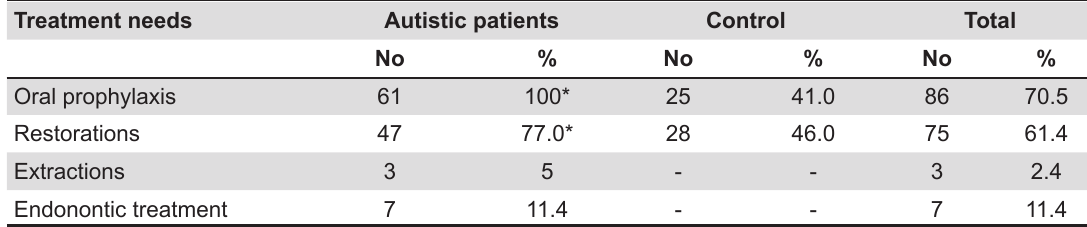
Table 3- Treatment needs of the of the autism group and healthy control subjects